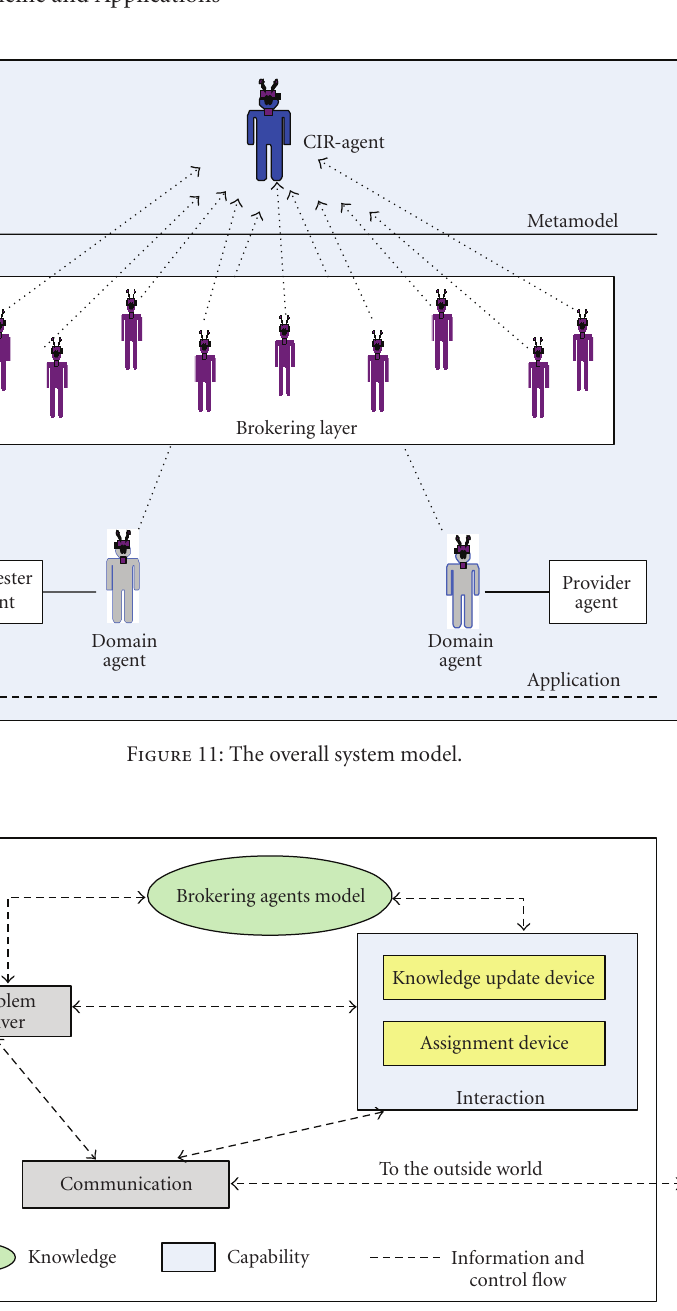
Figure 12: The domain agent